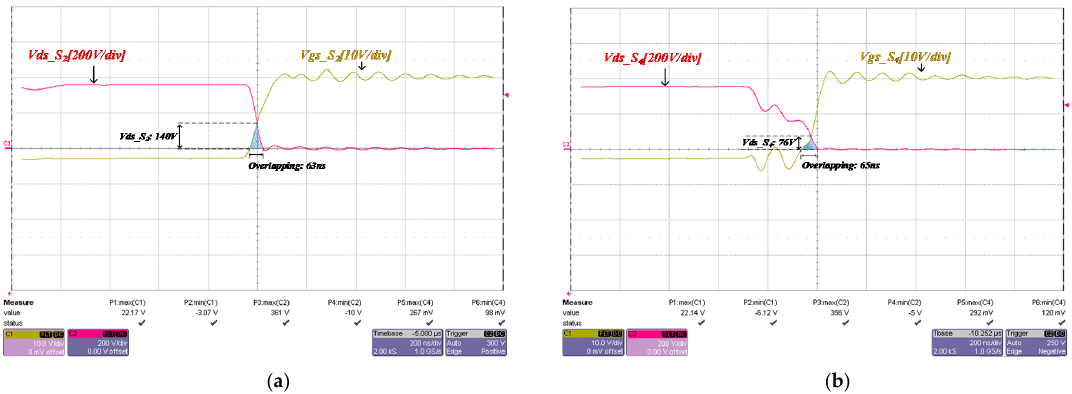
Figure 3. Resultant waveforms from the experiment of power device turn-on: ( a ) S 2 voltage waveforms of the leading leg, ( b ) S 4 voltage waveforms of the lagging leg.